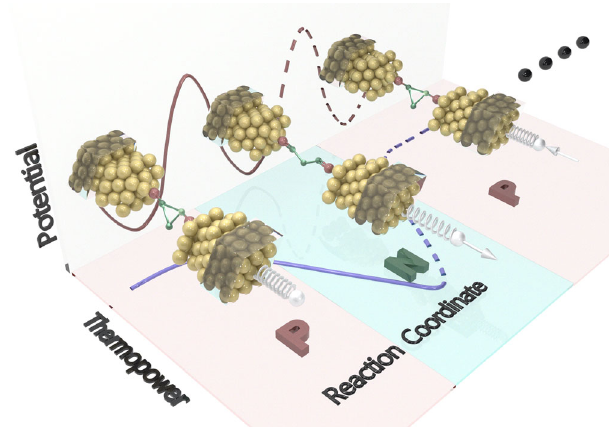
Fig. 1 Schematic illustration of mechanical-modulation and rever- sibility in a SMJ. Molecular structures of Au/CPDT/Au and Au/PDT/Au junction can be modulated by force-induced ring-opening/-closure reactions. The ring-opening reaction turns C – S bond into C = S bond and fl ips the nature of charge carrier from p-type to n-type. The ring- closure reverses the process of ring-opening reaction and fl ops the nature of charge carriers back to p-type. Yellow for Au; red for S; green for C. The hydrogens are removed for simplicity